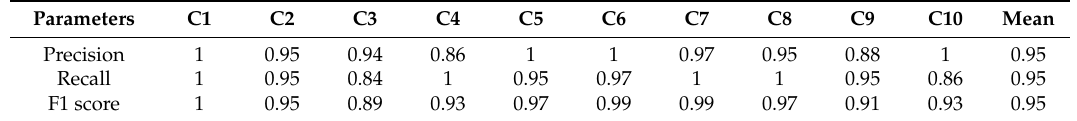
Table 4. Precision, recall and F1 score.